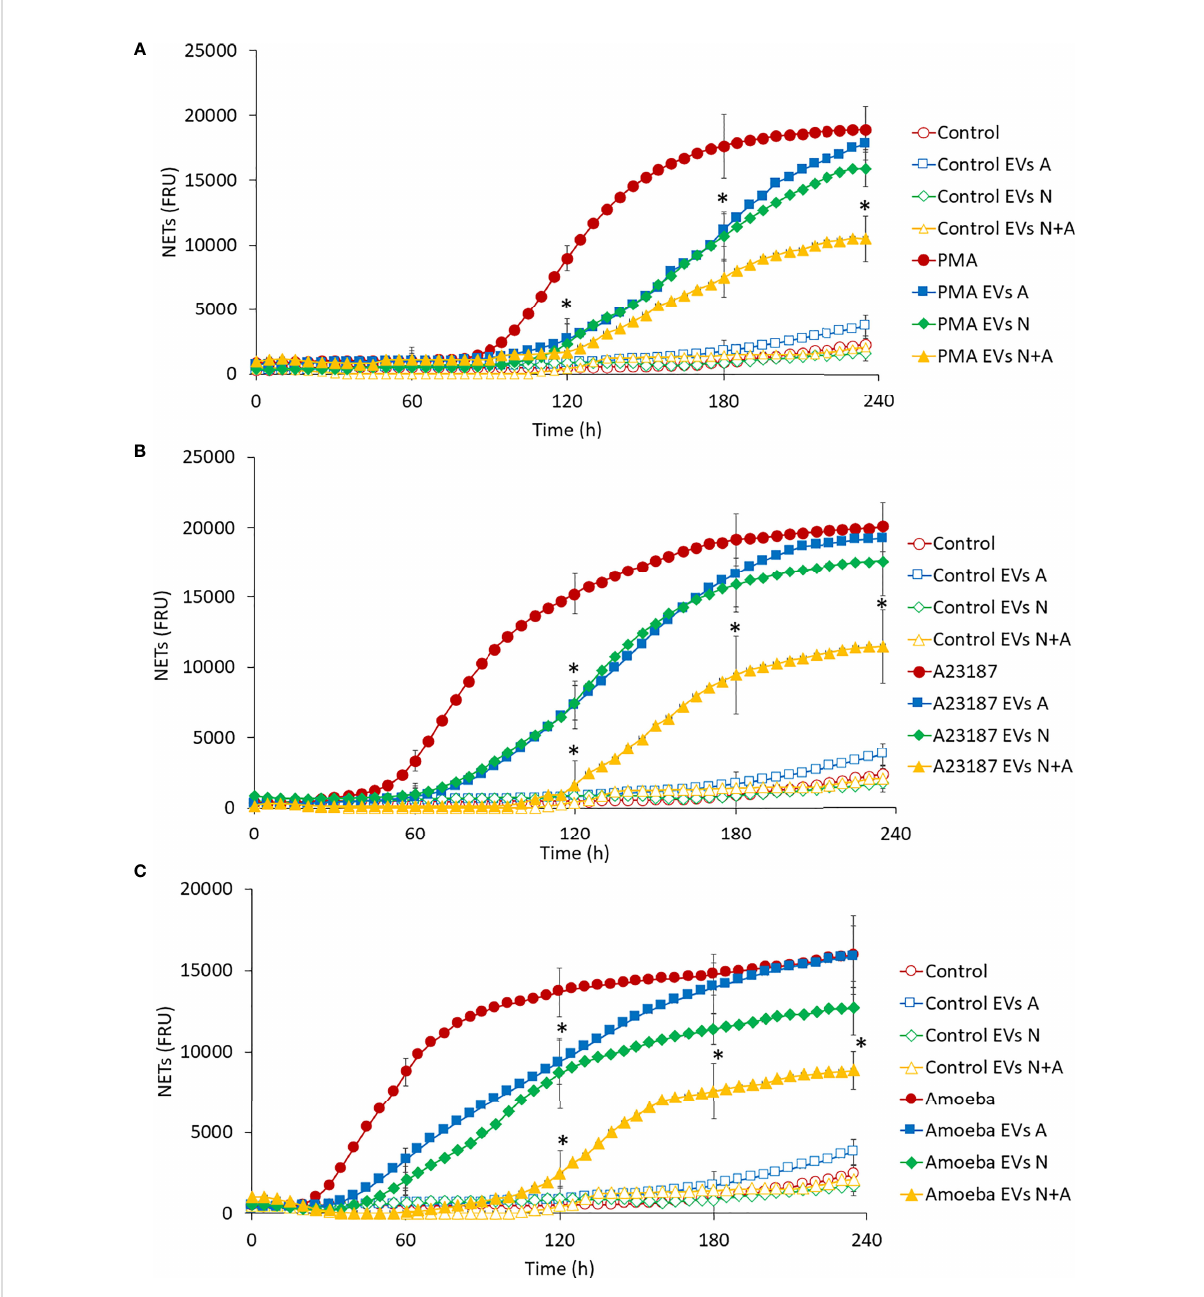
FIGURE 5 Effect of EVs on NET release in human neutrophils. Neutrophils (1 × 10 5 ) were culture in RPMI-1640 medium added with SYTOX ® Green and treated with EVs (10 µg of protein) from trophozoites, neutrophils, or coculture. Immediately, cells were stimulated or not with PMA (A) , A23187 (B) or 10 3 E. histolytica trophozoites (C) . Fluorescence was measured during 4 h and reported as fl uorescence relative units (FRU). Graphs represent mean of three independent experiments and ± SD was placed every hour. Measured controls were the same for all graphs. * p < 0.05; signi fi cant difference respect to stimulated neutrophils in the absence of